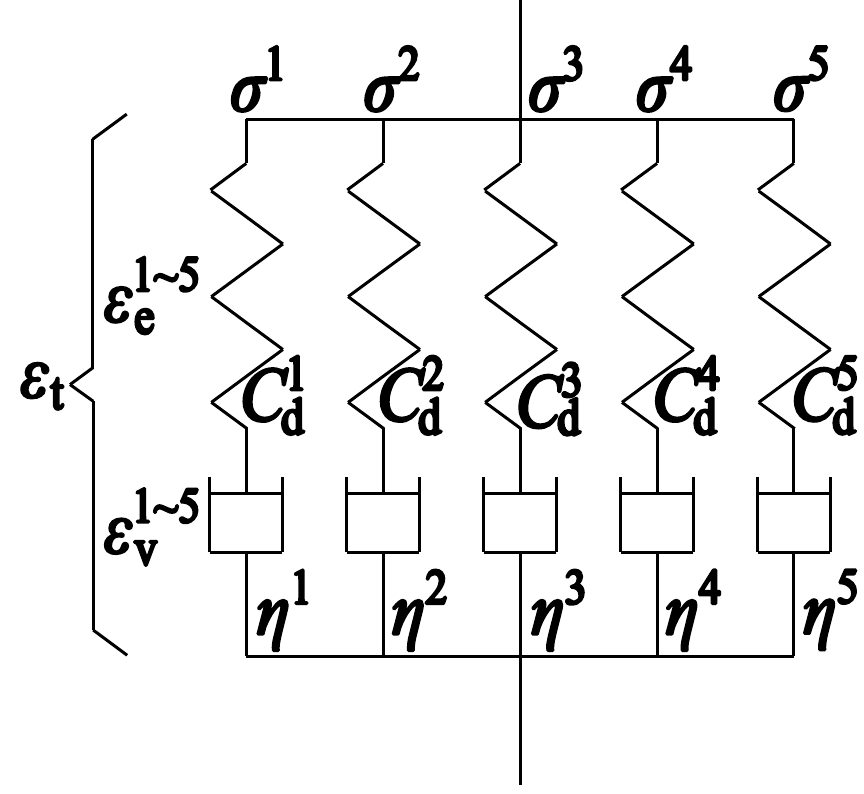
Figure 7. Five Maxwell elements aligned in parallel are adopted to model viscoelastic resin. Table 1. Material properties of viscoelastic Maxwell elements [41].